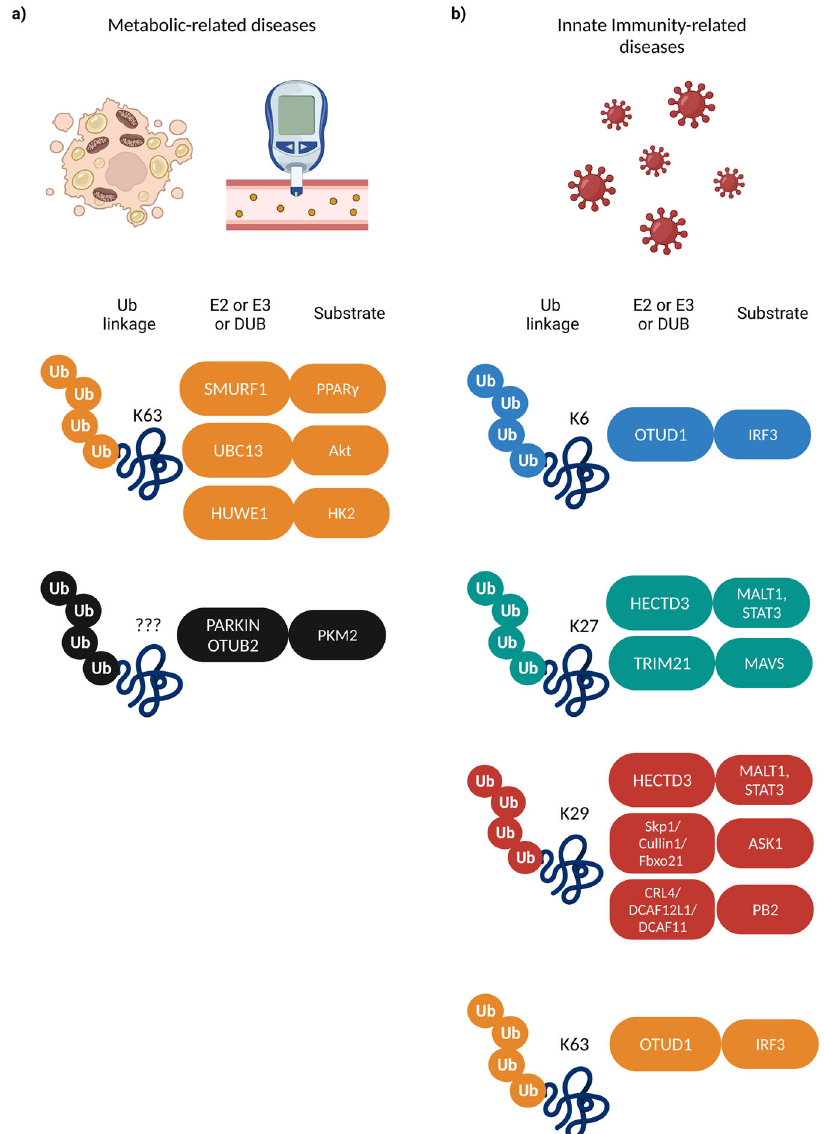
Fig. 5 Non-proteolytic ubiquitylation in metabolic and innate immunity related diseases. Examples of reported E2/E3/DUB enzymes (left boxes) and different non-proteolytic Ub signals on the substrate proteins (right boxes) regulating a metabolic and b innate